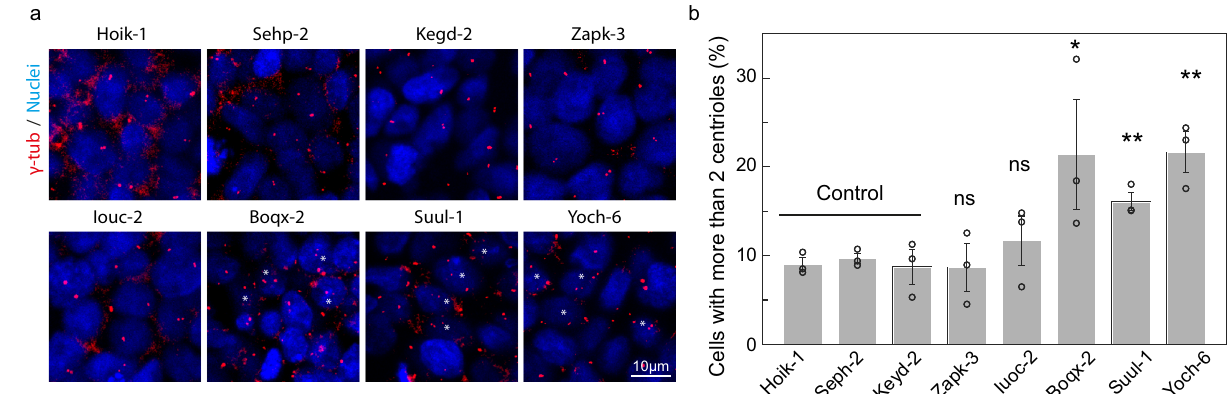
Fig. 4 | Experimental test for GO:0010826. This refers to 'any process that decreases the frequency, rate or extent of centrosome duplication'. a Representative examples of each of the indicated cell lines. Centrioles were detected by staining with gamma-tublin ( γ -tub), nuclei were stained with DAPI. Asterisksindicatecellswithmorethantwocentrioles.TheHoik-1,Sehp-2andKegd- 2 were control cell lines. b Histogram showing the percentage of cells with more